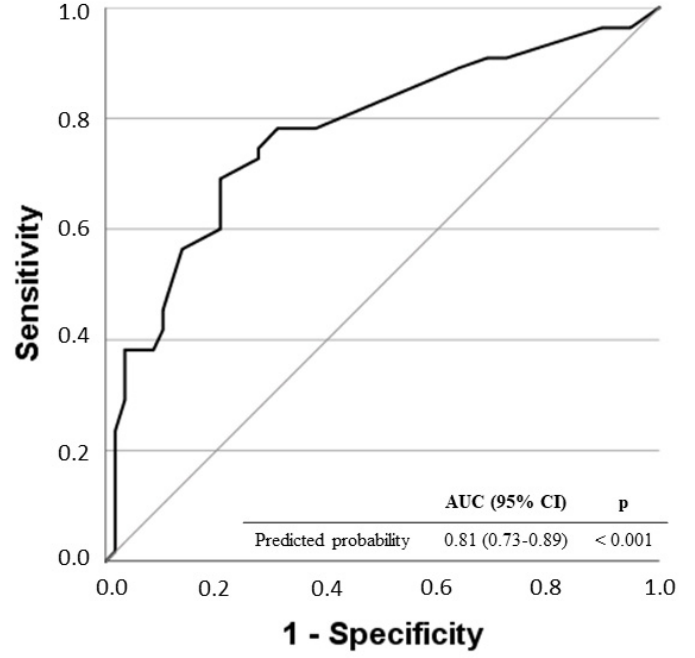
Figure 1. Receiver operating characteristic (ROC) curves for the predicted probability of the multi- variate logistic regression model for a NASH score of ≥ 4.